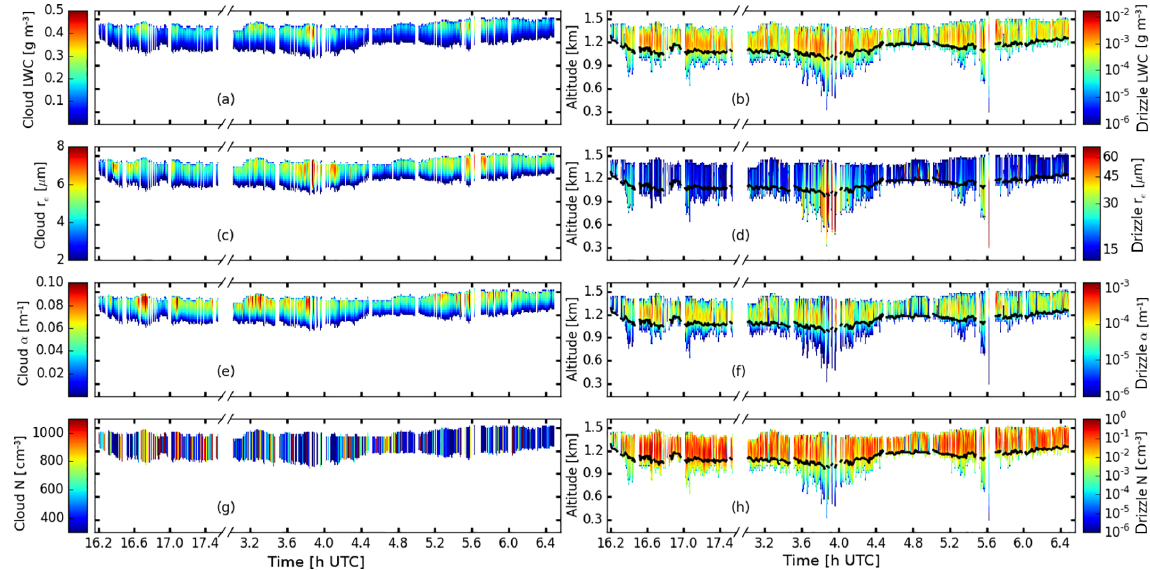
Figure 8. Optical and microphysical parameters of the cloud (a, c, e, g) and the drizzle (b, d, f, h) as obtained from the retrieval, as a function of time and height. From top to bottom: liquid water content, effective radius, extinction coefficient, and number